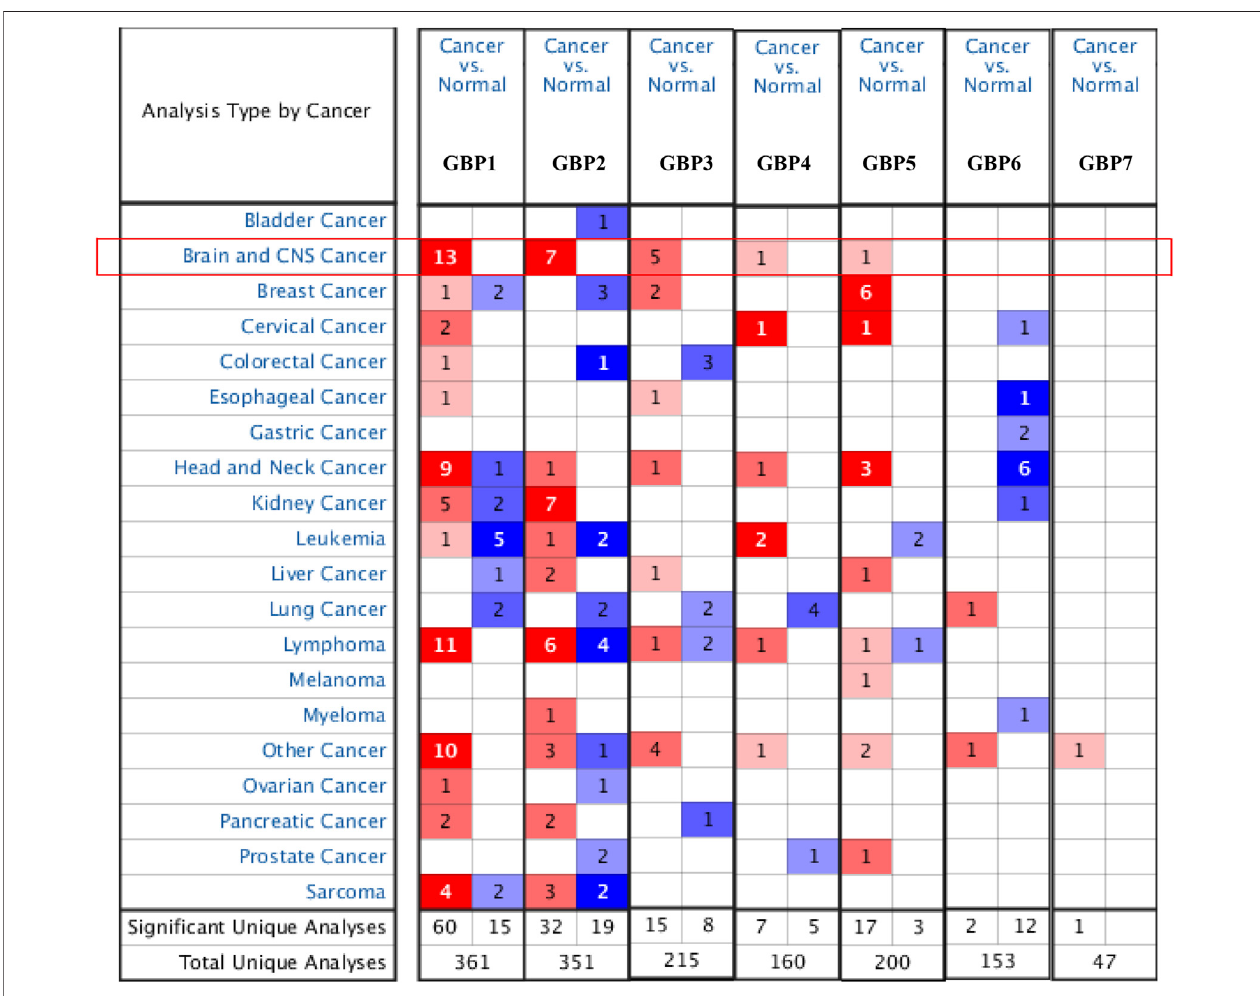
FIGURE 1 | The expression levels of guanylate-binding proteins (GBPs) in different types of cancers (Oncomine). The expression levels of GBP1, 2, 3, 4, 5, 6, 7 in different types of cancers. Red, over-expression; blue, downregulated expression.